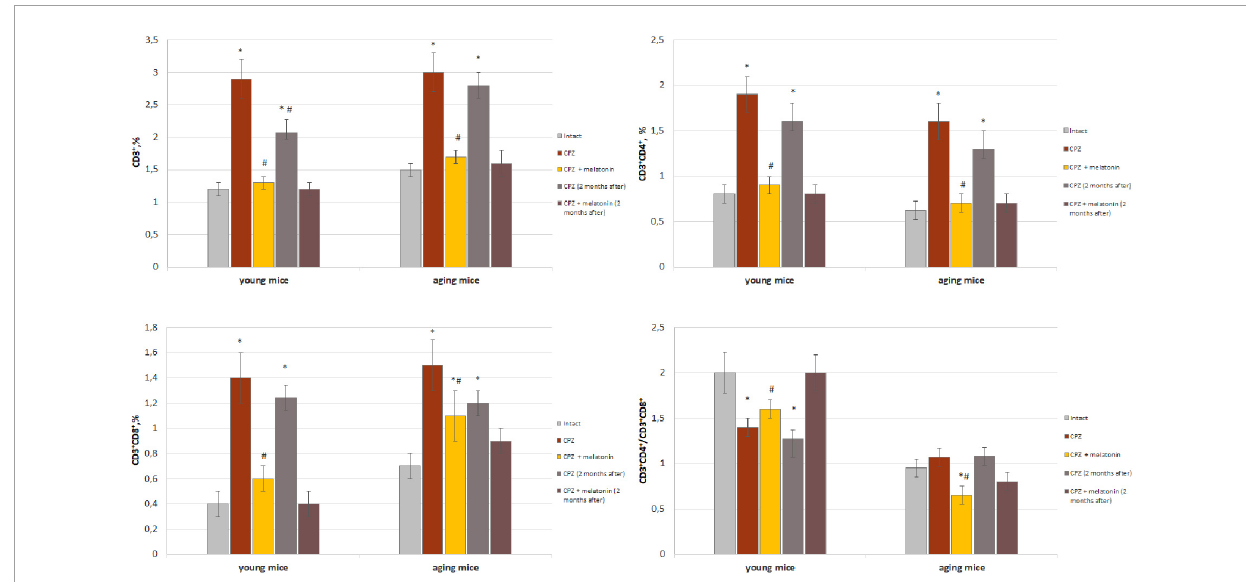
FIGURE1 Percentage of CD3+, CD3+CD4+, and CD3+CD8+ T cells from total brain cells and cell ratio of CD3+CD4+/CD3+CD4+ in brain of young and aging mice of experimental groups ( n = 5 in each group). Represented data are in 3 weeks of cuprizone (CPZ) diet and in 2 months after. Data are M ± SEM. ∗ p < 0.05 compared to intact group; # p < 0.05 compared to CPZ ( t